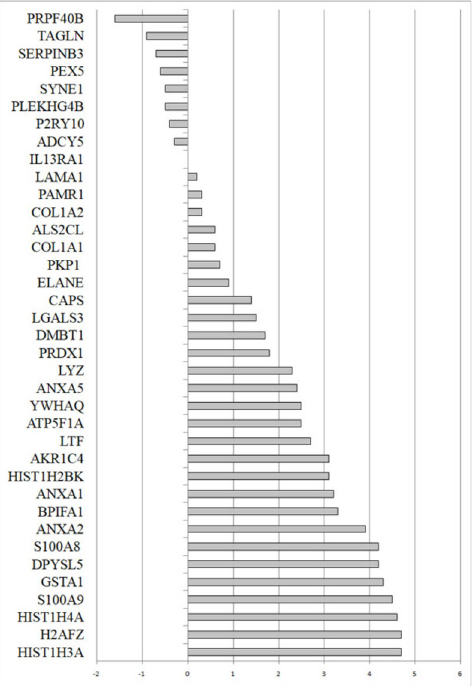
Fig 1. Proteins associated with SARS-CoV-2 infection. List of proteins associated with SARS-CoV-2 infected NOPS samples against control negative samples. The X-axis represents the protein expression level and Y- axis represents the